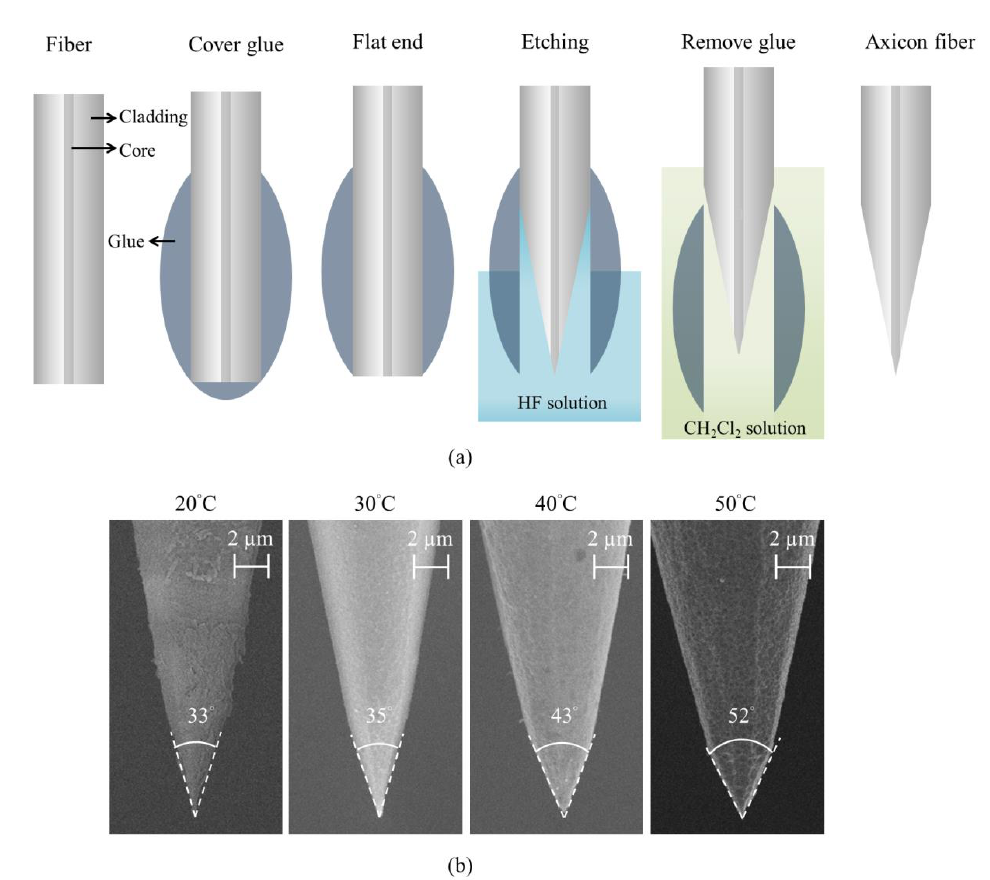
Figure 3. ( a ) Fabrication process from left to right; ( b ) the fabrication from a bare fiber to an